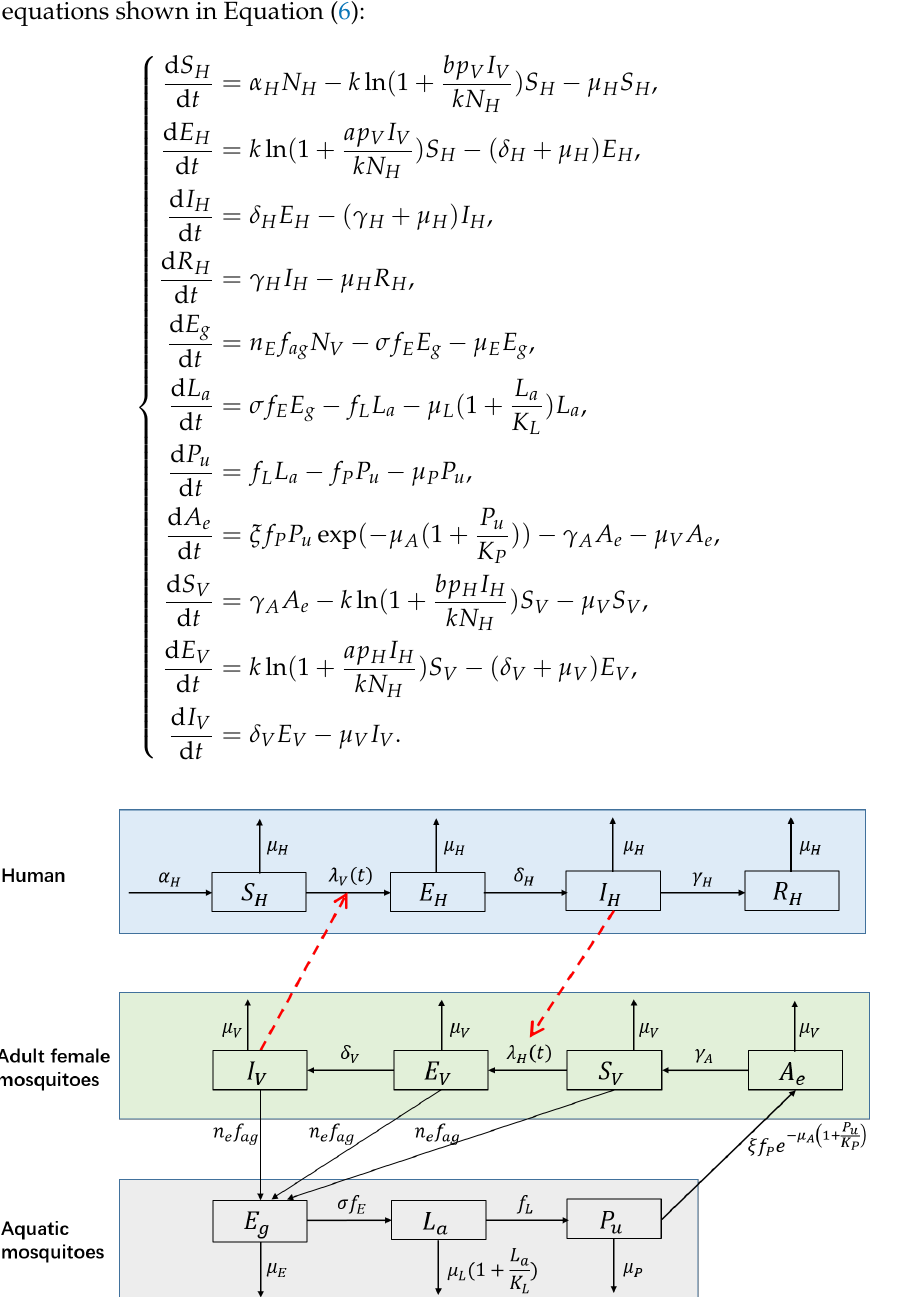
Figure 5. Flow diagram of the extended model with the aquatic phase of